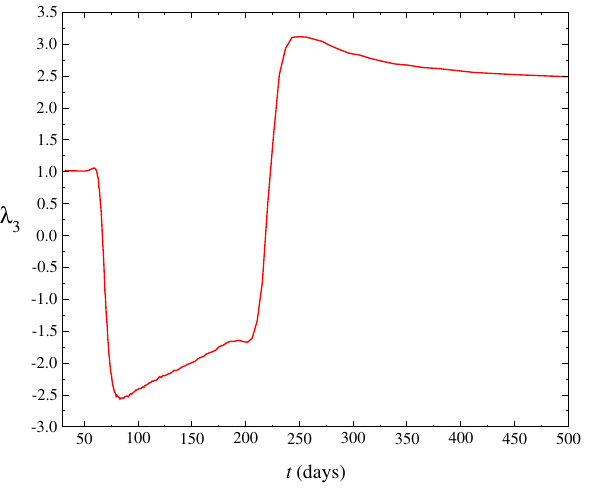
Figure 7. Behaviour of the skewness as a function of t (cid:31) 3 ( t ) . The negative (positive) values obtained give an estimating of the shape of distribution that becomes nearest of a Gaussian when (cid:31) 3